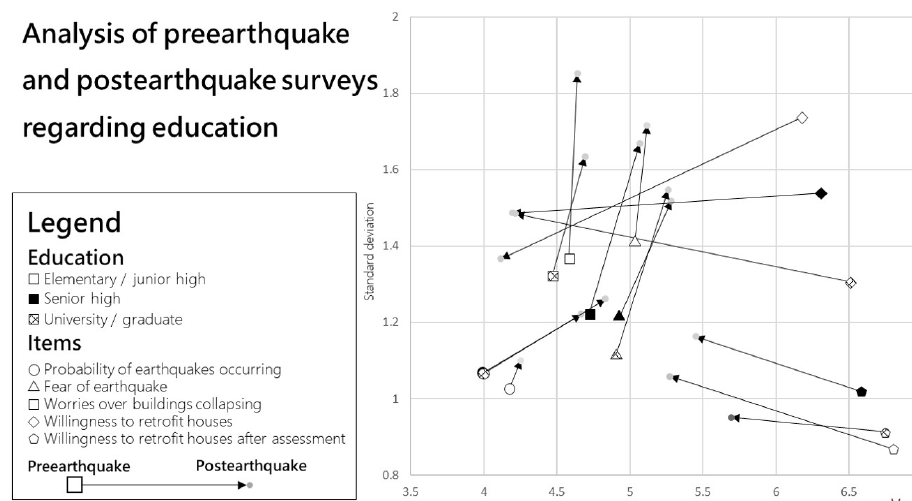
Figure 4. Comparative analysis of the pre- and postearthquake surveys regarding education.